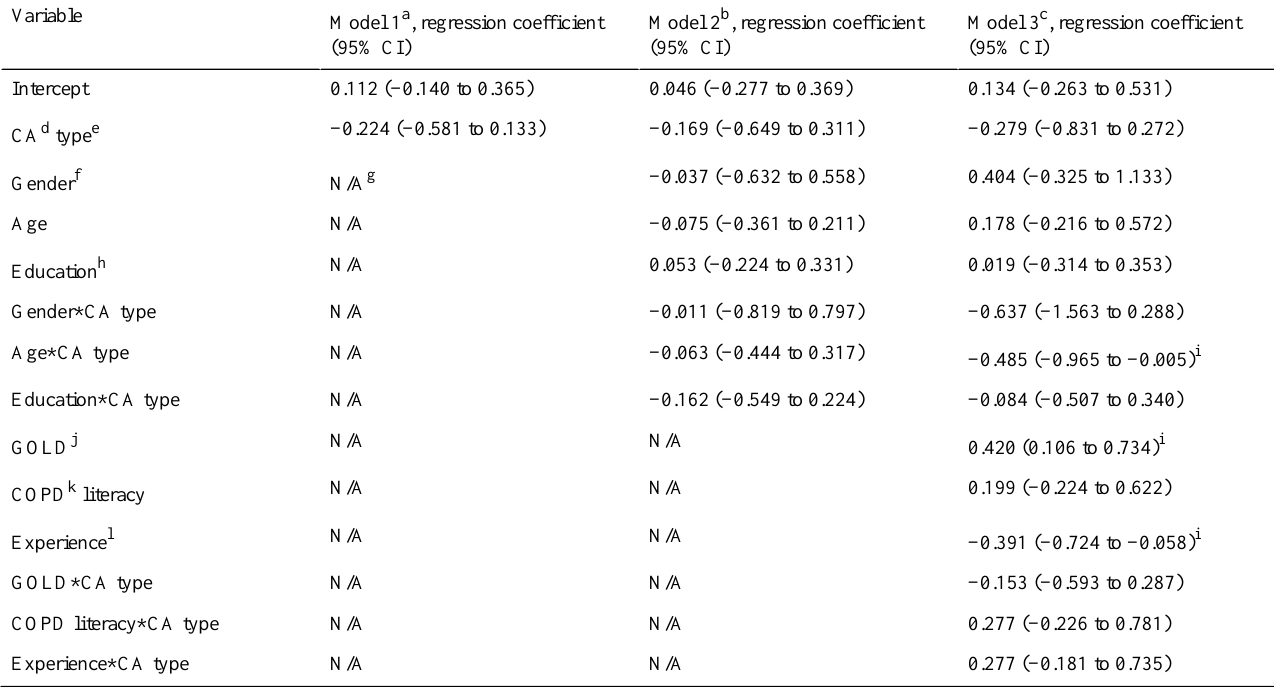
Table 9. Regression of conversational agent type, participants’ demographics, and chronic obstructive pulmonary disease–related characteristics in terms of participants’intention to continue interacting with the conversational